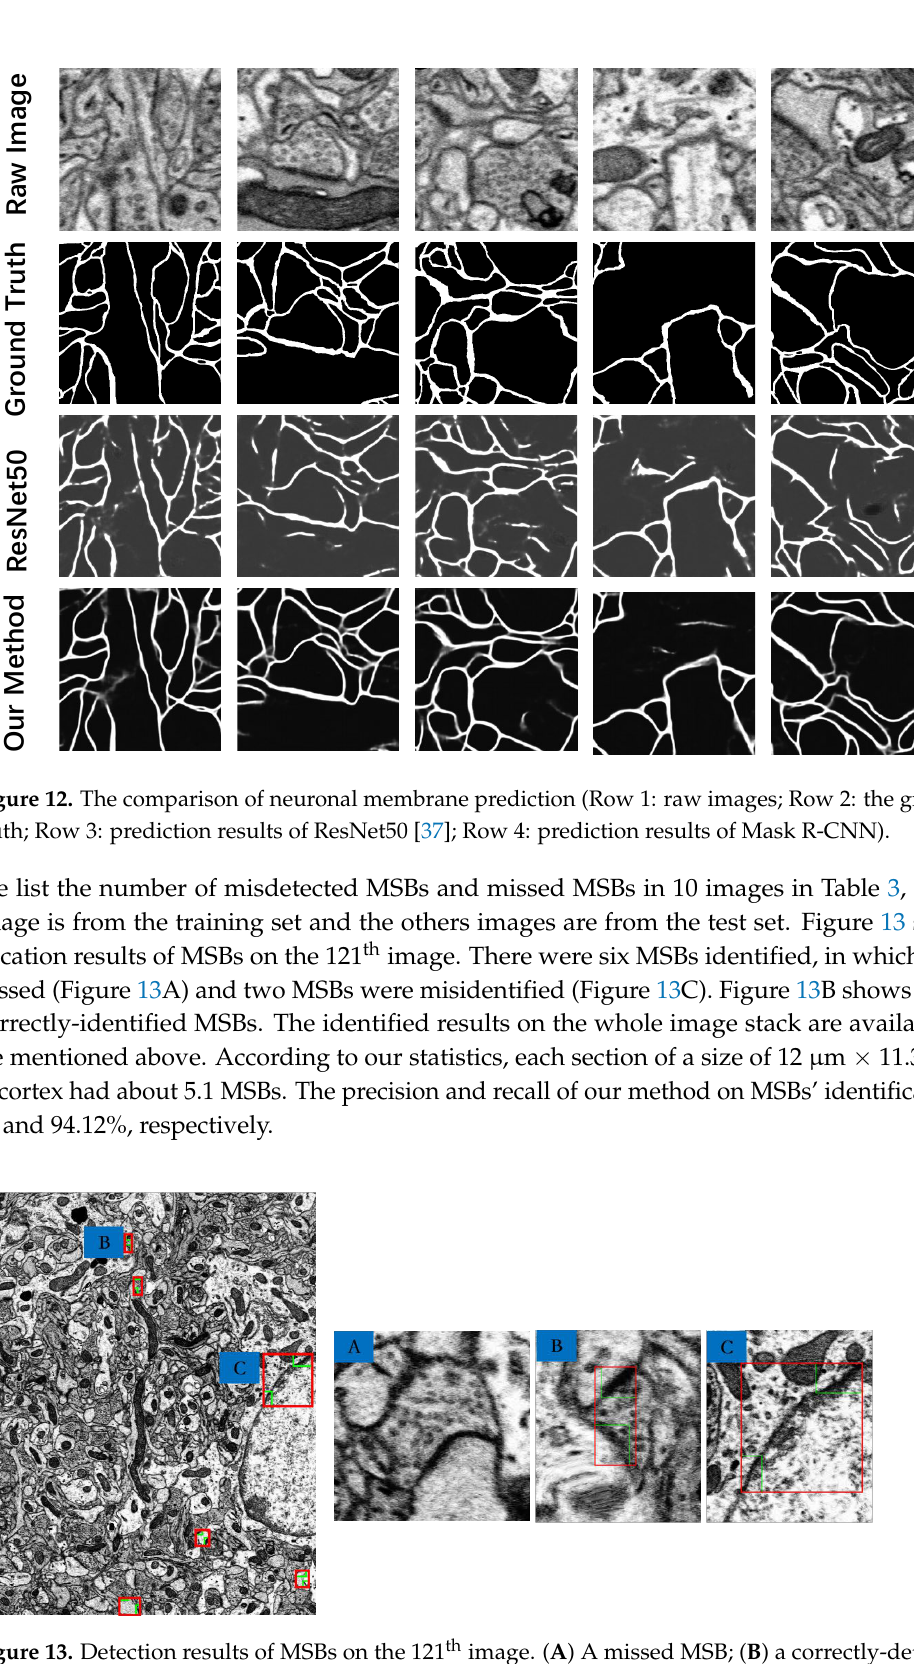
Figure 13. Detection results of MSBs on the 121 th image. ( A ) A missed MSB; ( B ) a correctly-detected MSB; ( C ) a misdetected